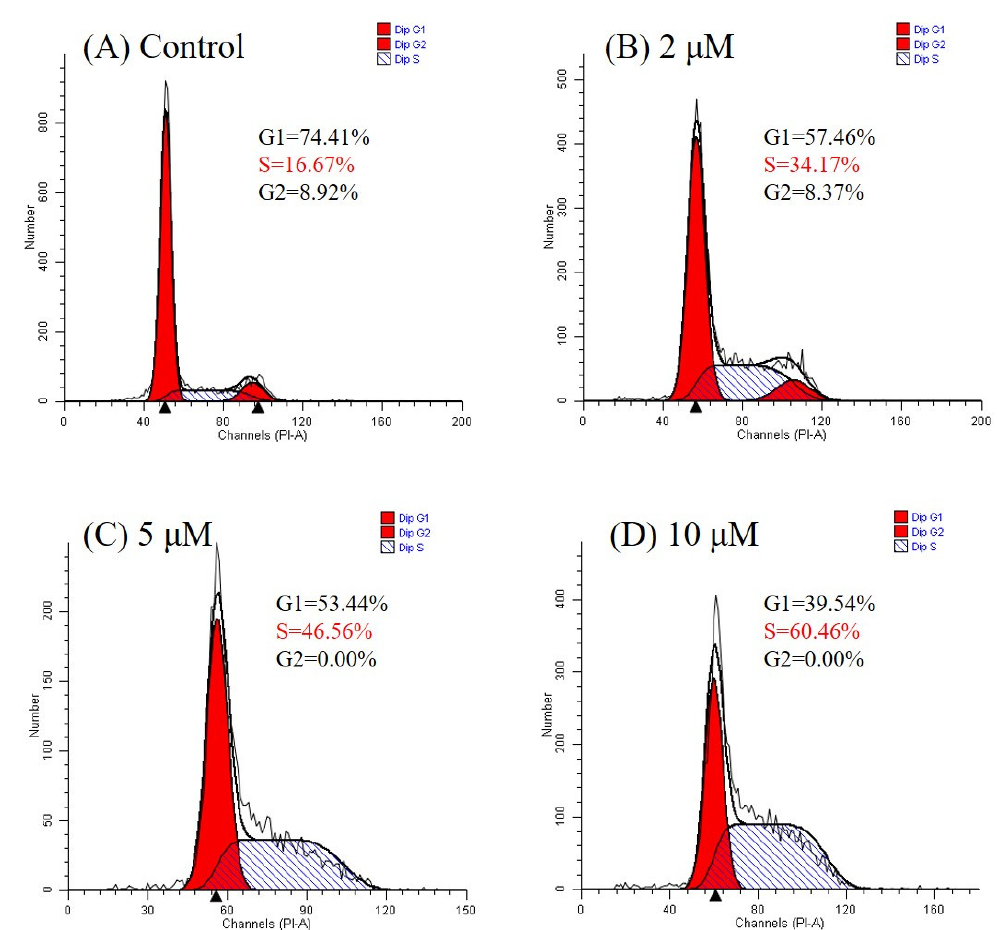
Figure 8. Cell-cycle distribution of A549 cell lines after treatment with compound 9 at different concentrations: ( A ) control group; ( B ) 2 µM; ( C ) 5 µM; ( D ) 10 µM.